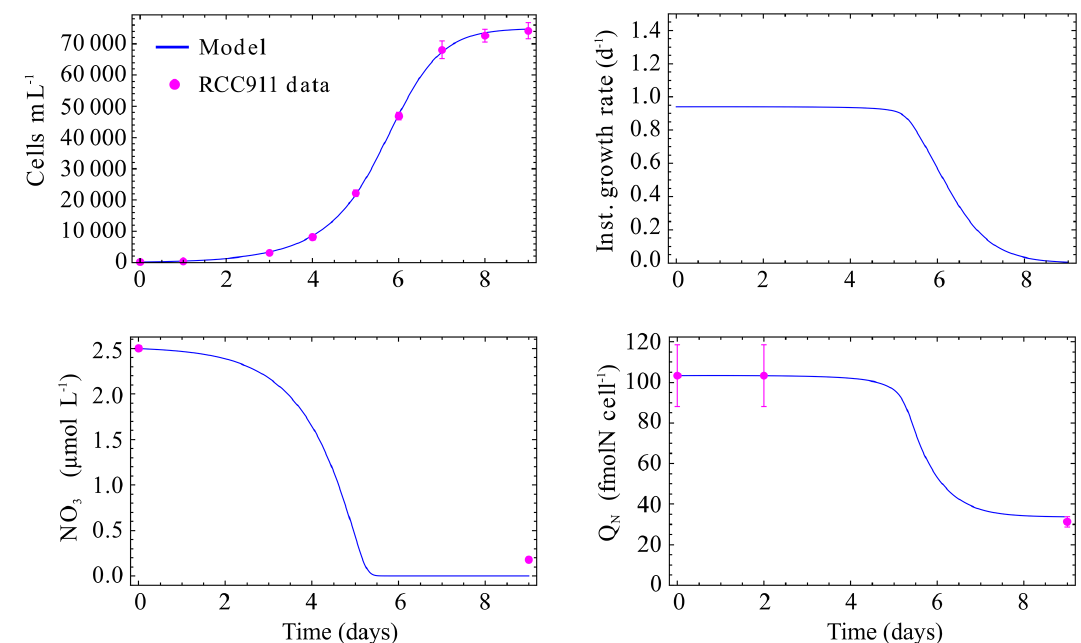
Figure 6. Model fitted to the data of the nitrate-limited cultures of strain RCC911 in high-light